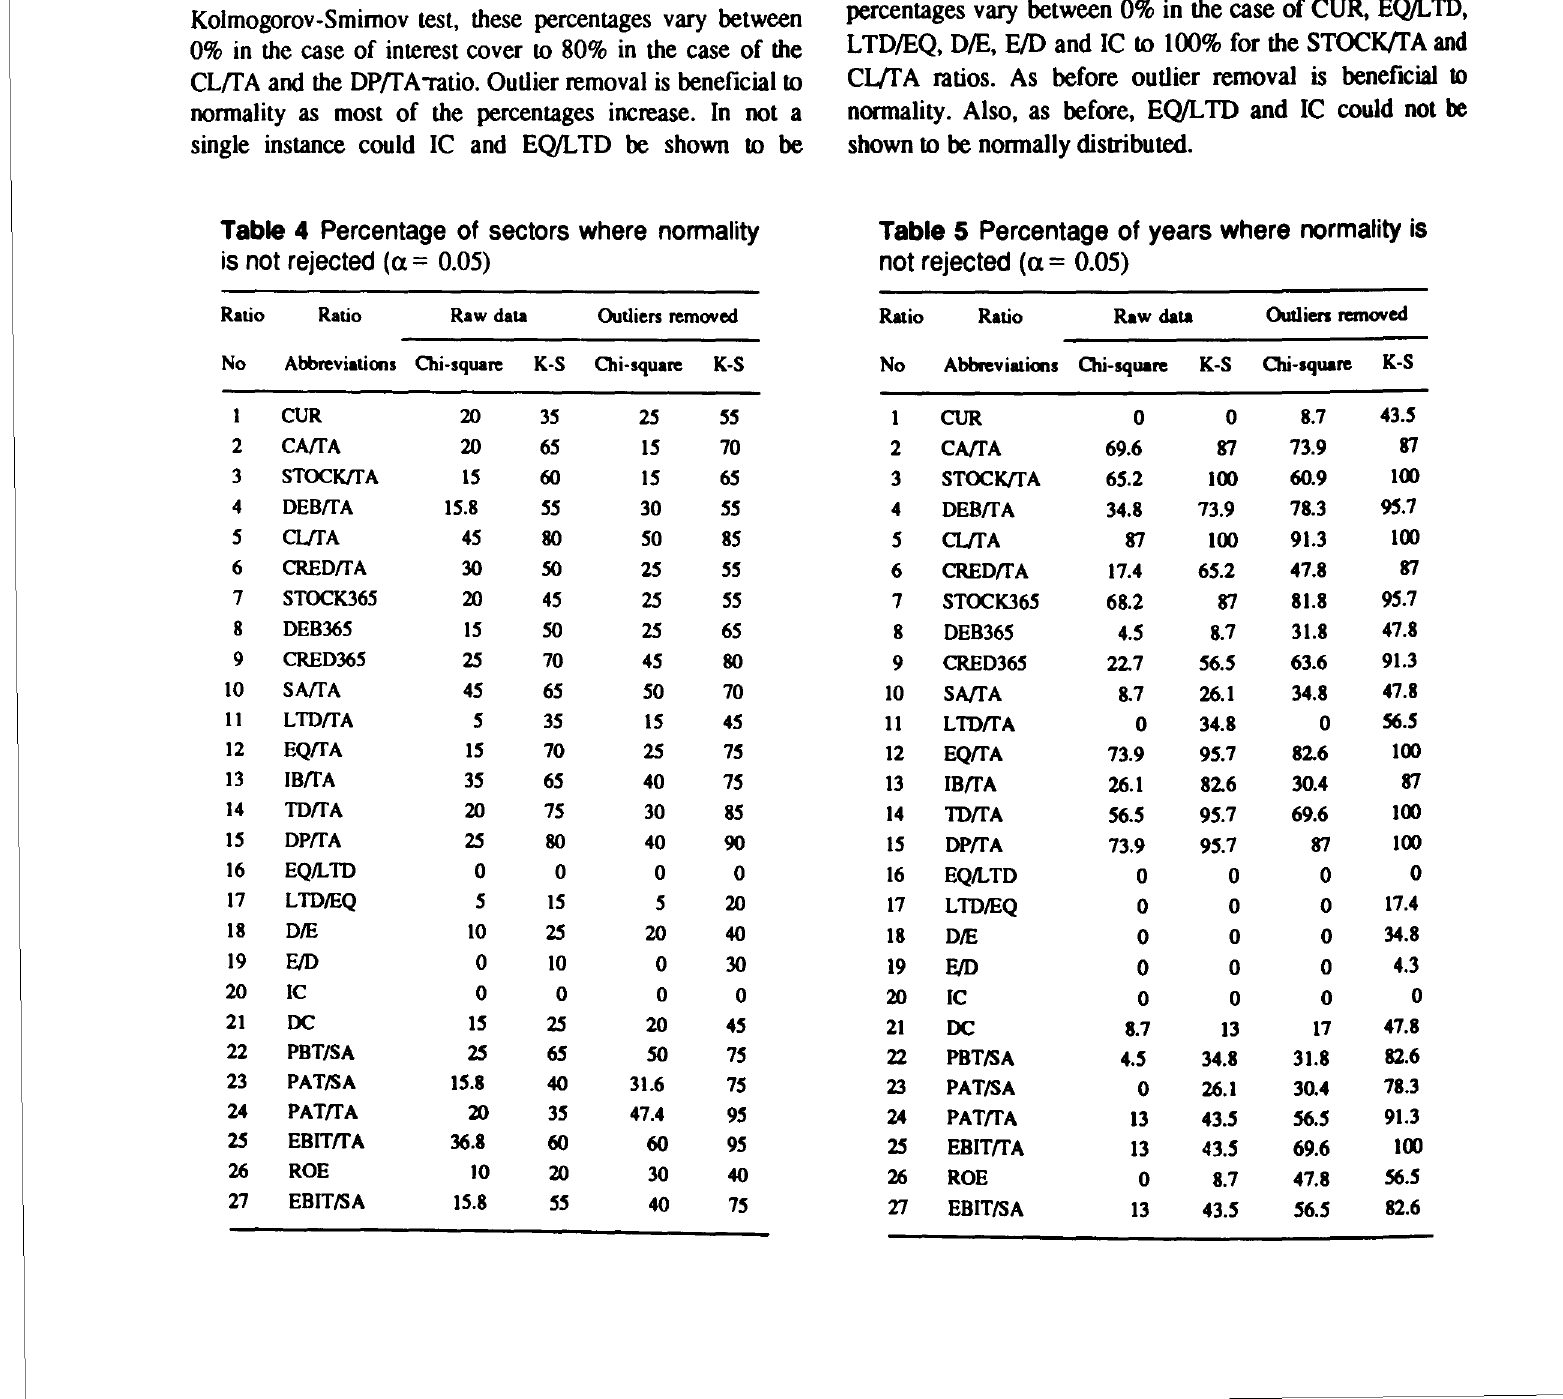
Table 4 Percentage of sectors where normality Table 5 Percentage of years where normality is is not rejected (a=